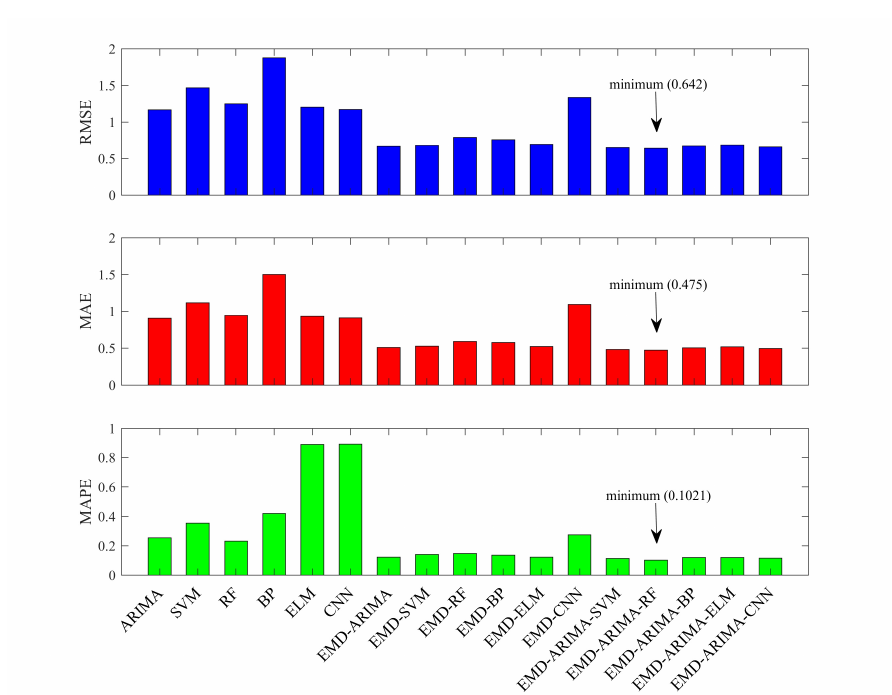
Figure 13. Wind speed prediction comparisons for the 1 h data at the HLJ